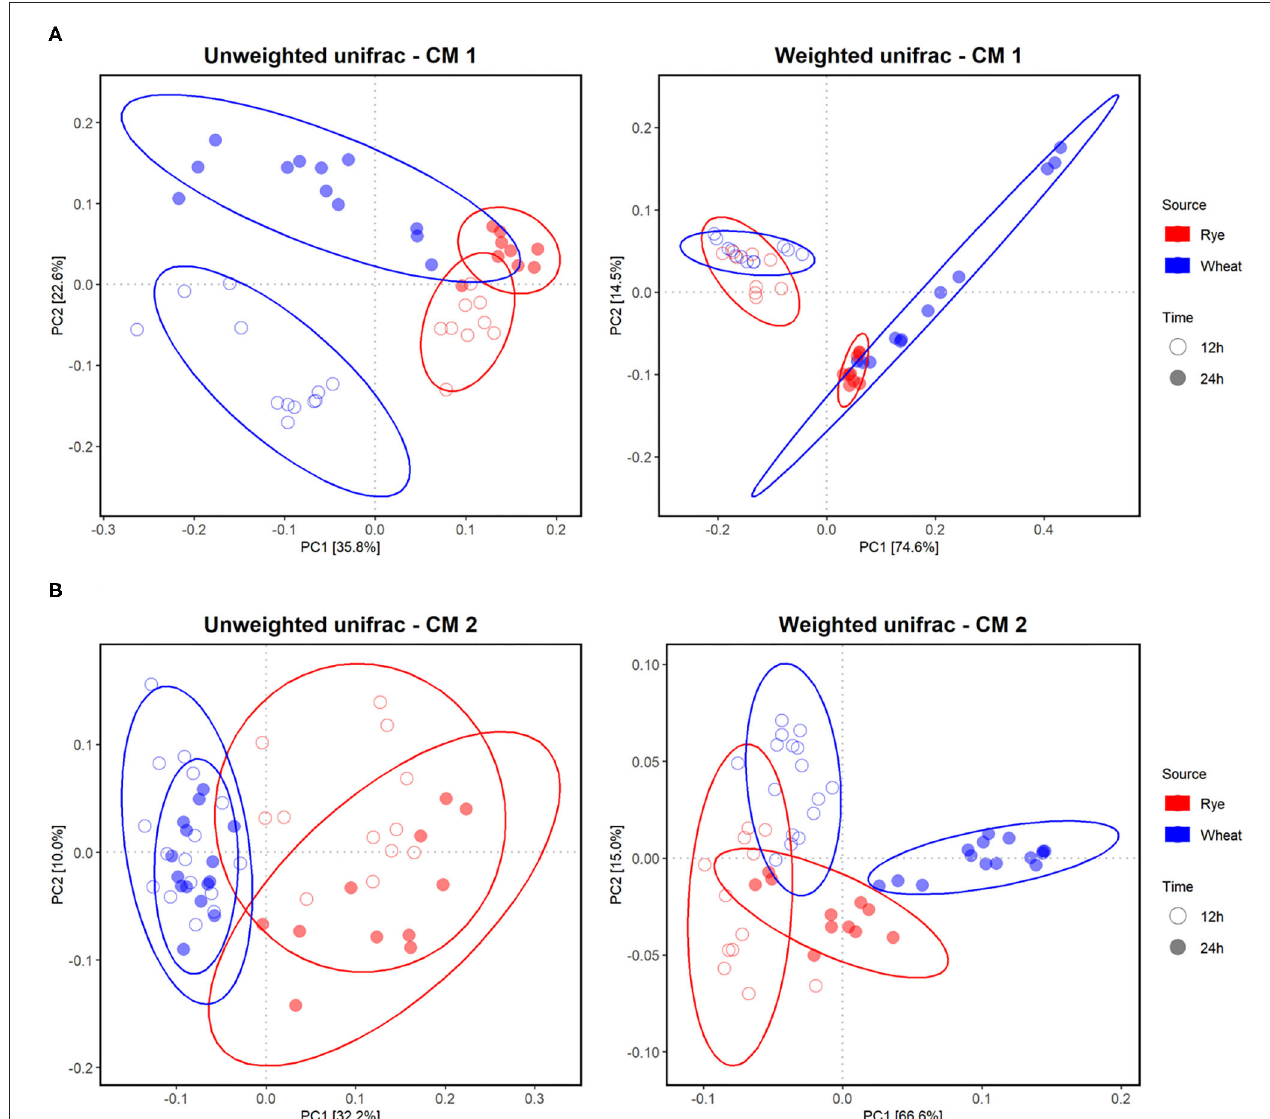
FIGURE 4 | Effect of different AX sources, namely, WBAX (blue) and RFAX (red), on the in vitro colon microbiota composition in CM 1 (A) and 2 (B) . Principle Coordination Analysis (PCoA) of incubated microbiota based on the unweighted and weighted UniFrac analysis matrix on ASV level. Each point represents an in vitro colon microbiota sample after 12 ( ◦ ) or 24h (•) of fermentation. Ellipses indicate 95% confidence